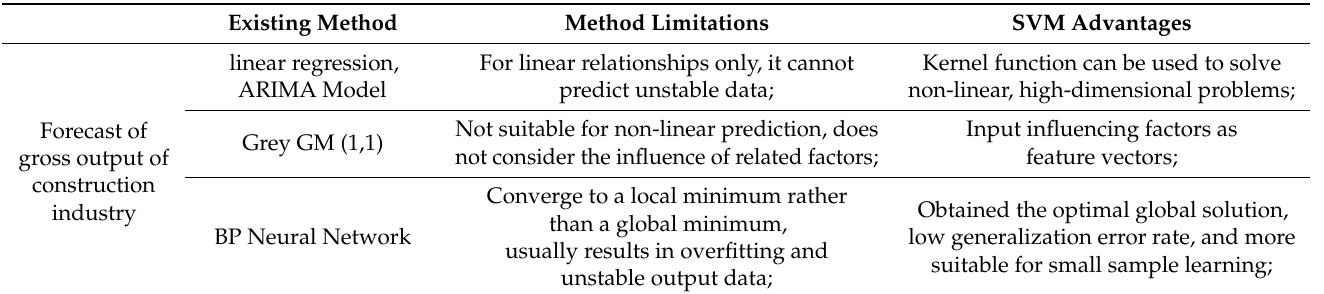
Table 1. Comparative analysis of existing